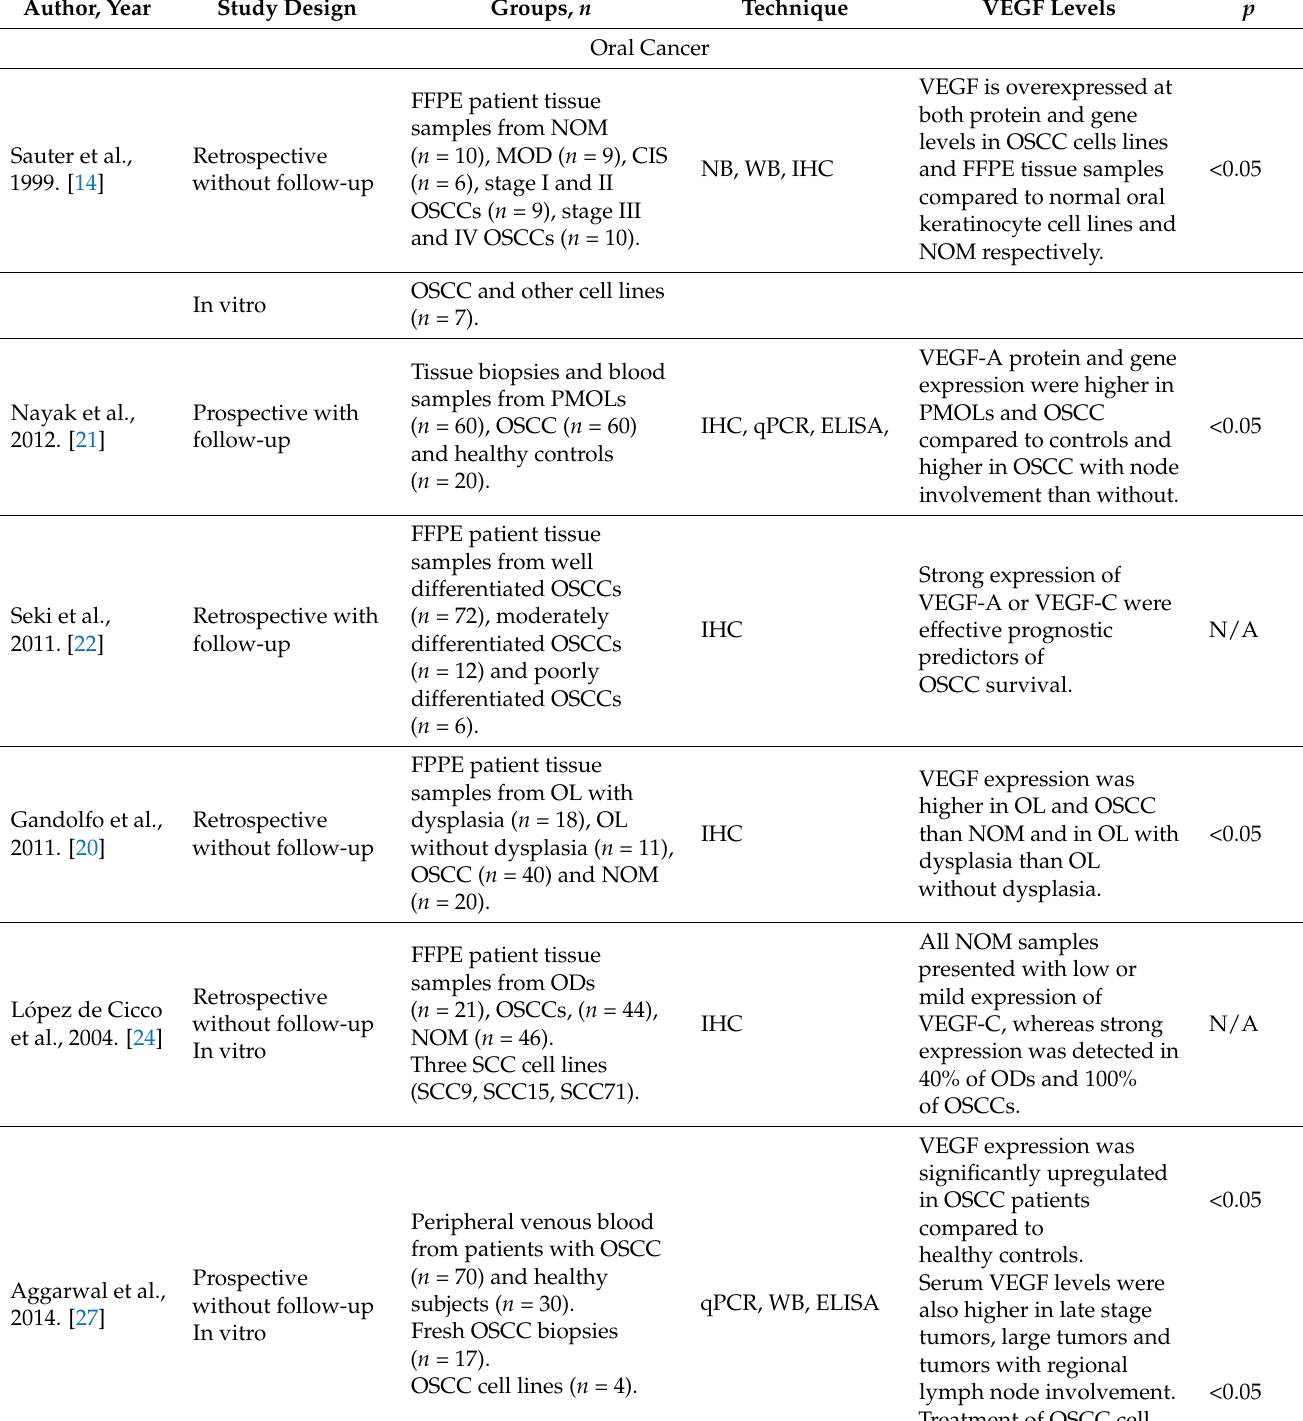
Table 1. VEGF in oral diagnostics of oral non-communicable